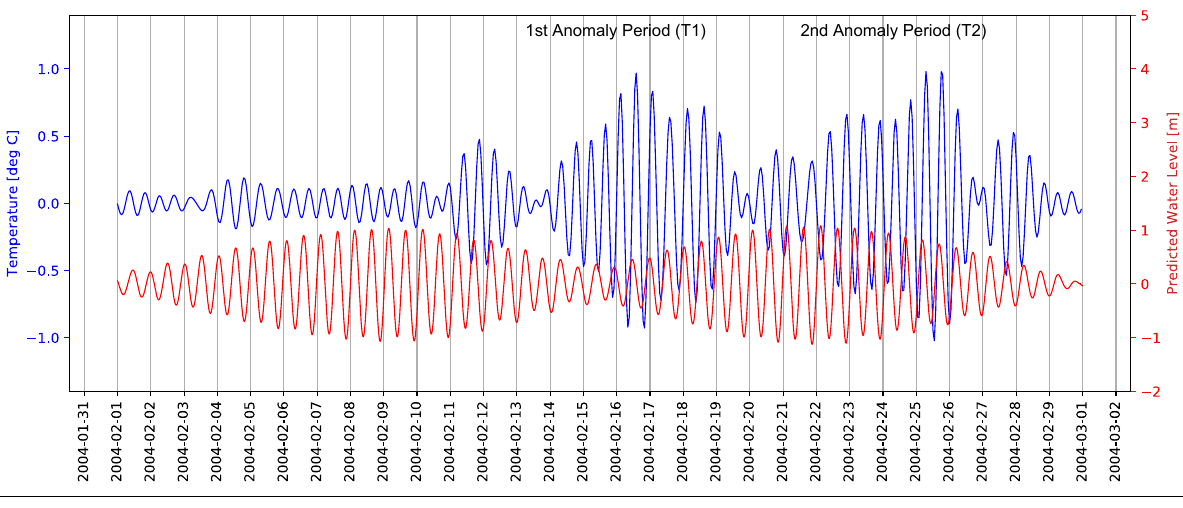
Figure 3: Time series of tidal temperature signal. The temperature signal is presented in blue and the predicted water levels are presented in red. The first anomaly period (T1) refers to the temperature anomaly that peaked on 14 February 2004 and the second anomaly period (T2) refers to the temperature anomaly that peaked on 23 Ferbruary 2004 (see Figure 2).